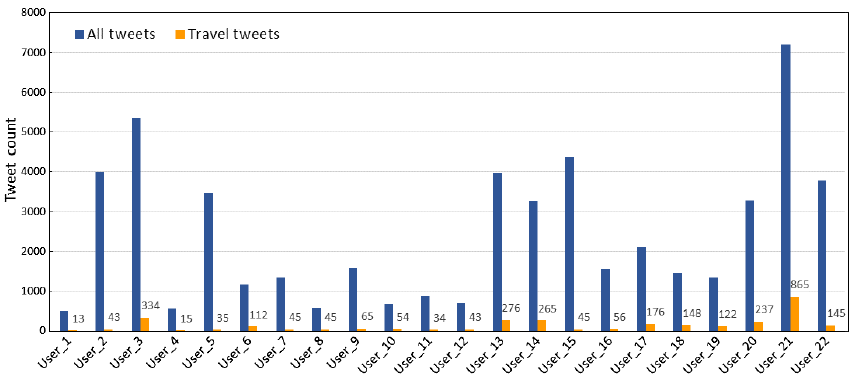
Fig. 5 User specific tweet count: All tweets vs. travel tweets.